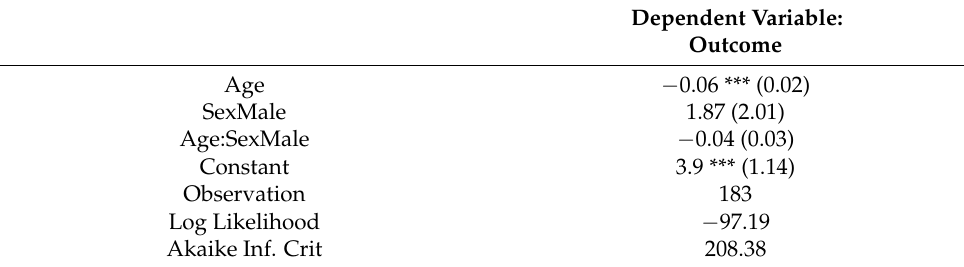
Table 9. Coefficients of model without HLA